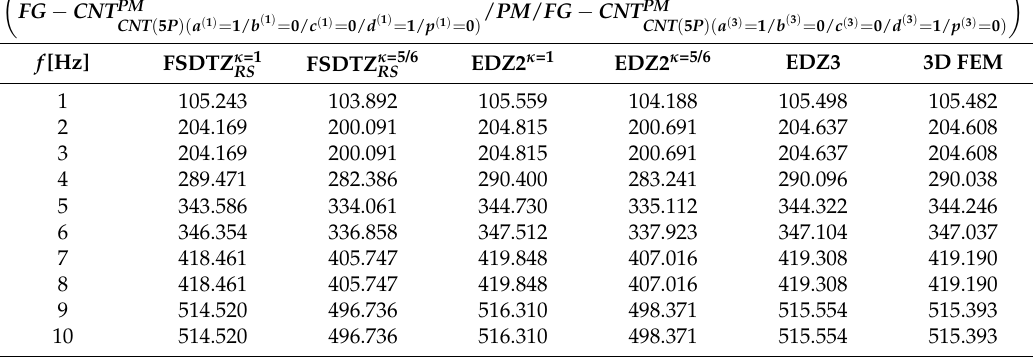
Table 3. Comparison between the first ten natural frequency variations of a CCCC square plate made of a 3-layered material (CNT/matrix/CNT) with various thickness h = 0.02m/0.06m/0.02m given by GDQ method and FEM. The 3D FEM solution was obtained by commercial software Strand7. Lamination Scheme: